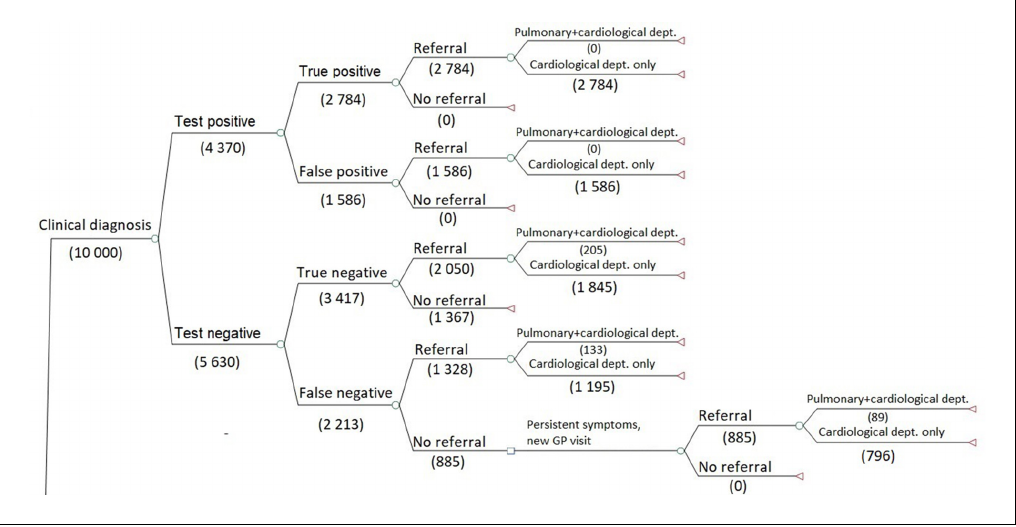
Figure 2. Key structure of the decision model for hospital test (the number of patients is used for illustrative purposes).